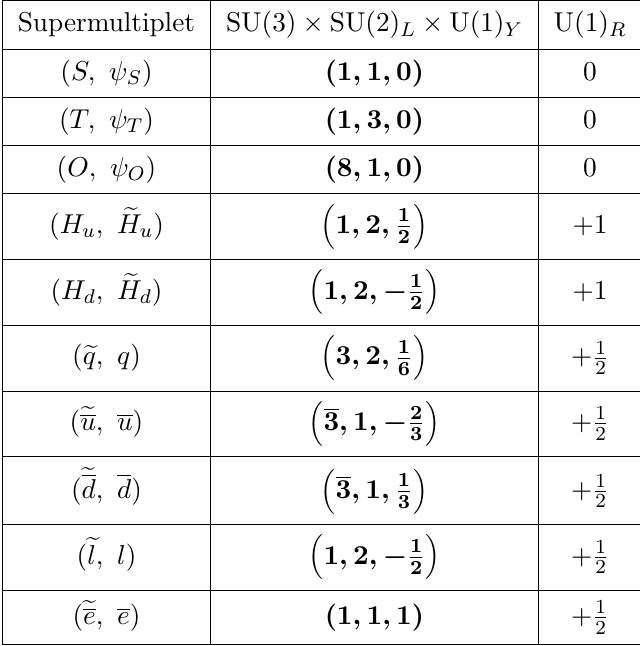
Table 1 . The particle content of this model, along with gauge quantum numbers and the R - charge of the scalar part of the multiplet. These assignments of R -charge allow each term of the superpotential to have the necessary R = 2 . Here we use the two-component fermion notation of [25, 26], in which e = e R † and so on. Note that there is freedom to choose different R for the squark and slepton fields, so long as the charges of corresponding left and right chiral fields add to